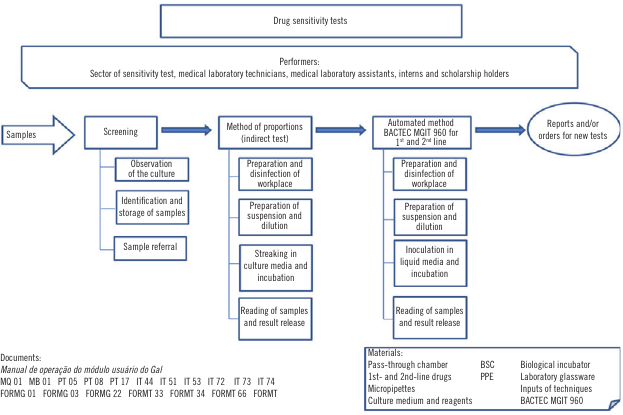
figurE 7 – Flow chart of the sensitivity test assay